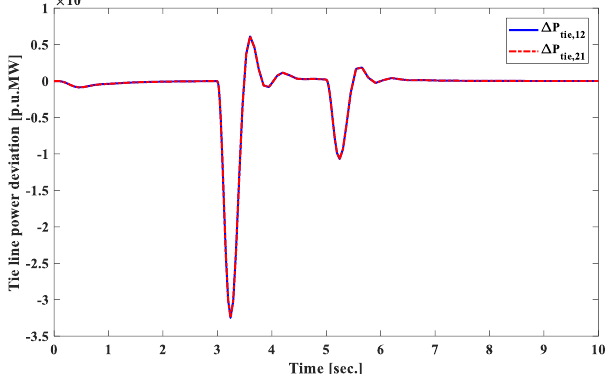
Figure 3. Tie line power deviation [p.u.MW] with matched disturbances.